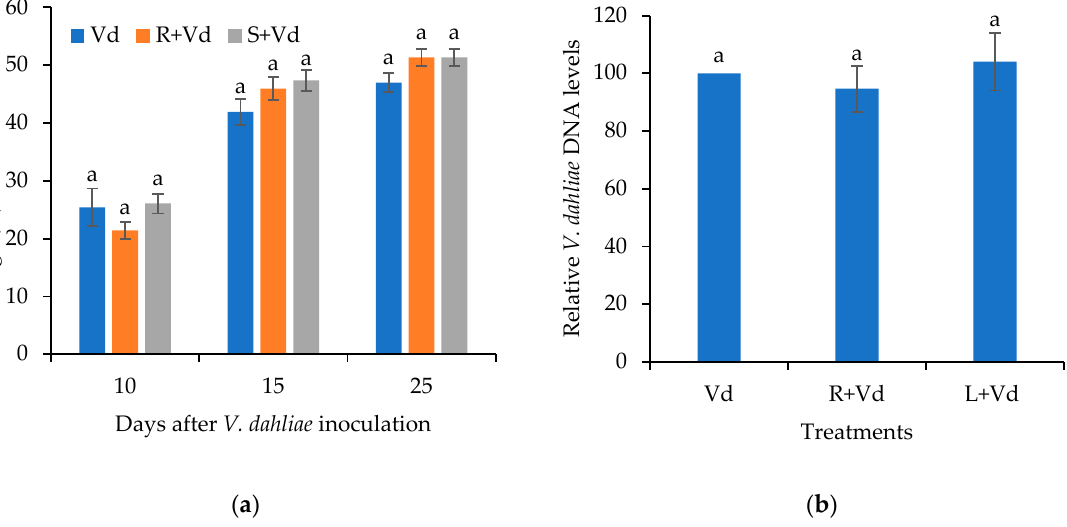
Figure 6. Disease severity and relative quantification of the V. dahliae DNA levels in A. thaliana , cerk1 , leaf injected (L + Vd) or root drenched (R + Vd) with autoclaved spores of V. dahliae or mock inoculated (positive control, Vd) and inoculated after 3 days with V. dahliae . Fungal DNA levels were estimated at 25 dpi. In ( a ), columns represent means of three replications per treatment ( n = 30 plants, ± SE) and in ( b ) they represent means of three biological and technical replications per treatment ( n = 9, ± SE) at 25 dpi (end of pathogenicity experiment). In ( b ), the control treatment (Vd) is set to 100%. Different letters denote statistically significant differences between treatments ( p < 0.05) according to LSD test. For disease severity, statistics were performed at each time